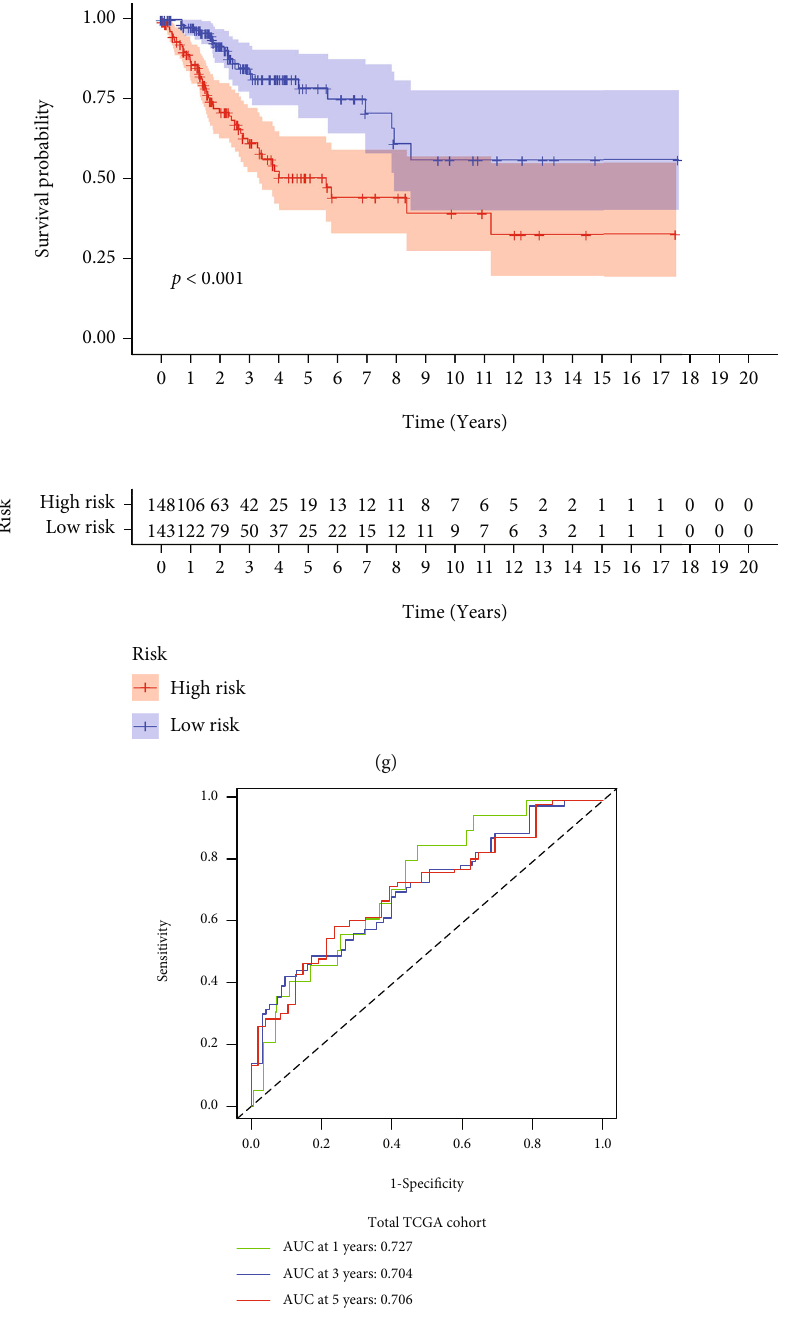
Figure 4: Construction and validation of ferroptosis typing-related gene signatures. (a, c, e, g) K-M survival curves of high- and low-risk groups in training set, validation set, GEO cohort, and TCGA total cohort. (b, d, f, h) ROC curves of 1, 3, and 5 years for training set, validation set, GEO cohort, and TCGA total